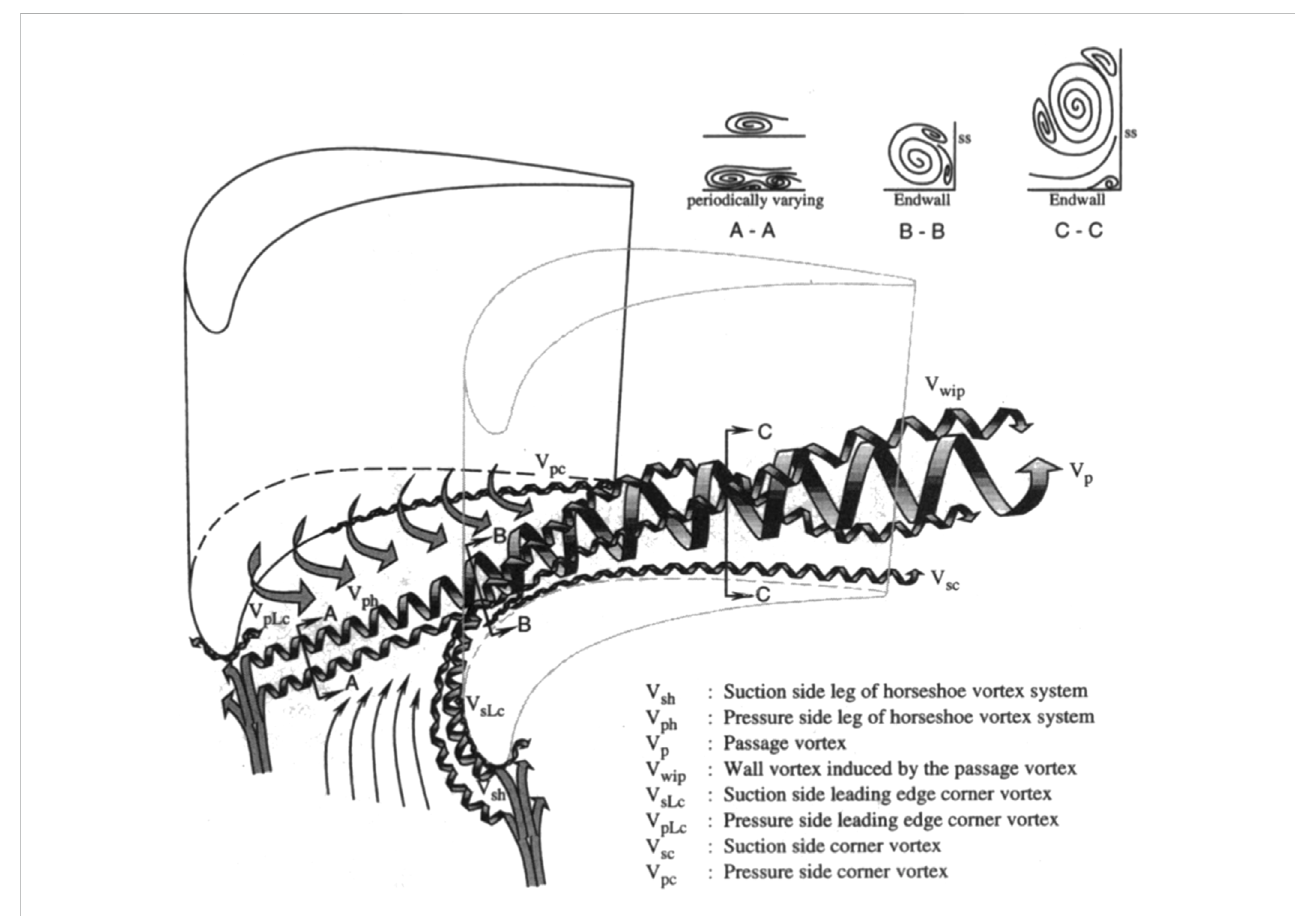
FIGURE 2 Flow structure in the endwall region (Wang et al., 1997).